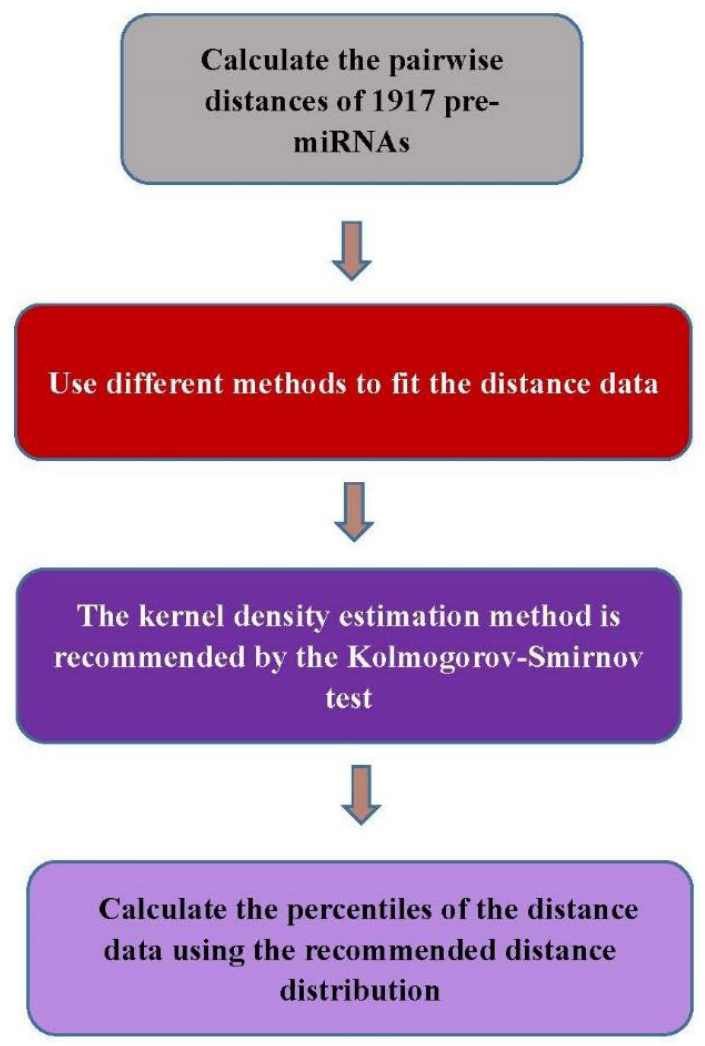
Figure 6. The flowchart of the method.